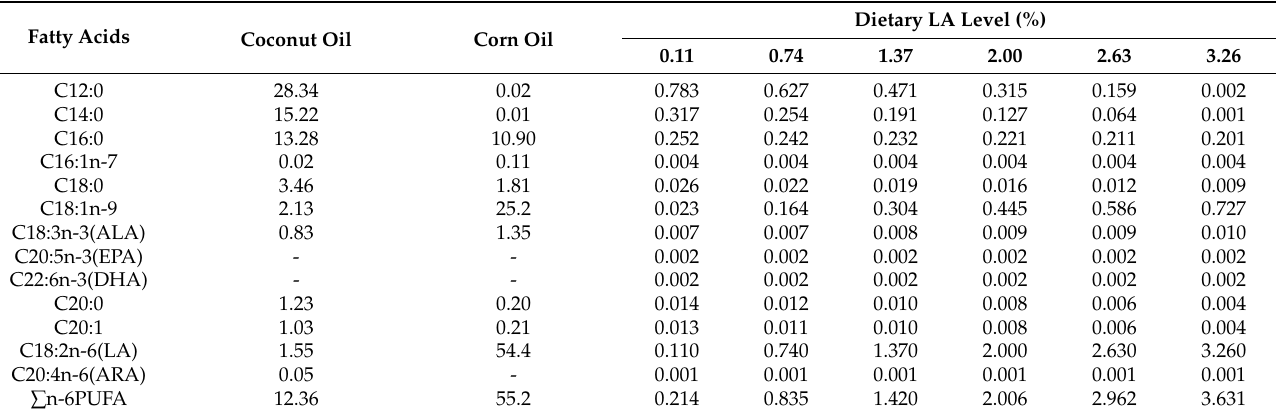
Table 2. Fatty acid composition dry matter of lipid ingredient (% total FA) and experimental diets